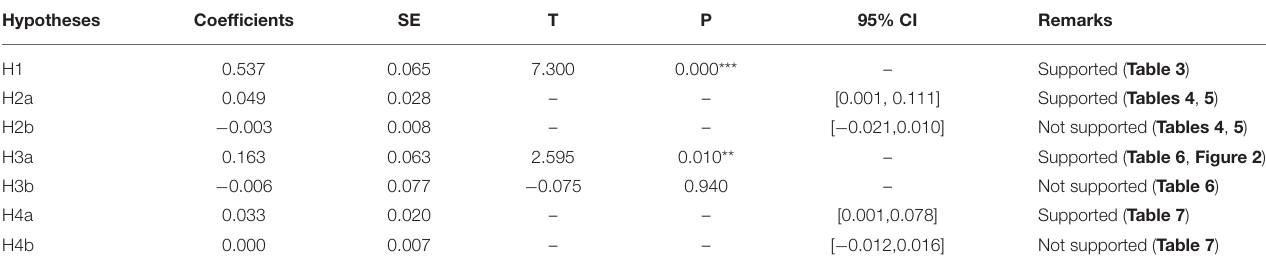
TABLE 8 | Results of hypotheses